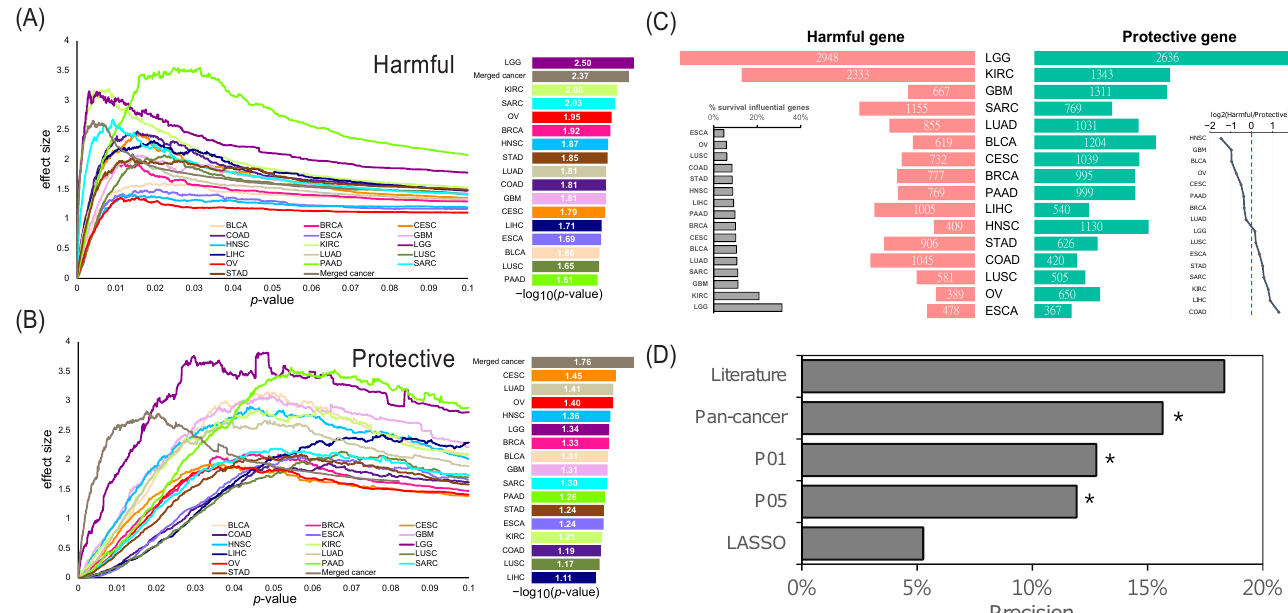
Figure 1. Summary of the survival-influential genes in cancers. ( A , B ) The effect sizes of the different threshold p -values for each cancer type. The effect sizes of p -values were estimated via 1000-time permutation test. The p -value producing the largest effect size (right panel) was denoted as the cut-off of significance level for identifying survival influential genes. ( C ) The number of identified survival influential genes in each cancer type. Red and green bars represent harmful and protective genes respectively. The proportion of survival influential genes and the ratio of harmful to protective genes in each cancer genome are also displayed. ( D ) Cancer association of the SIGs. Precision is the proportion of cancer-associated genes in the SIGs identified from LASSO (Cox regression model with LASSO regularization), P05 and P01 (Cox regression model with the threshold of p -value < 0.05 and 0.01), pan-cancer, and the literature. An asterisk signifies a significantly large proportion of caner-associated genes ( p -value < 0.05, Fisher’s exact test) in the corresponding